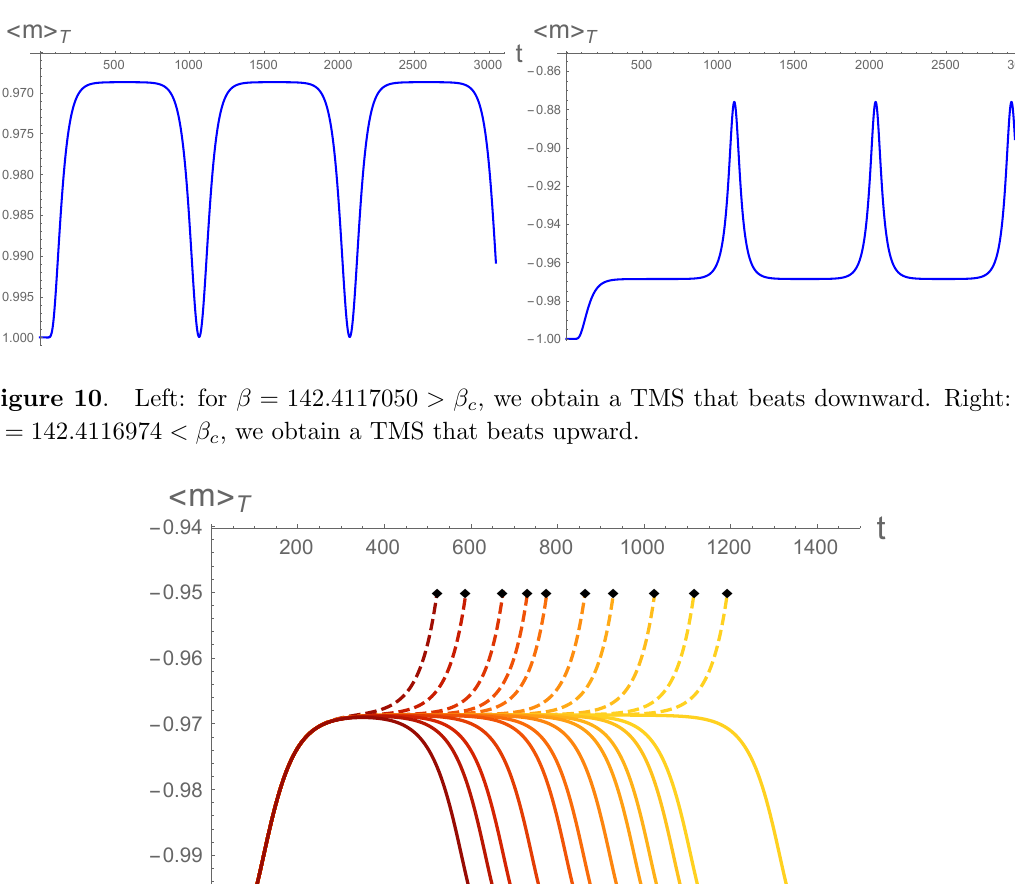
= (cid:0) 0 : 95 for the T reaches its (cid:12)rst minimum T